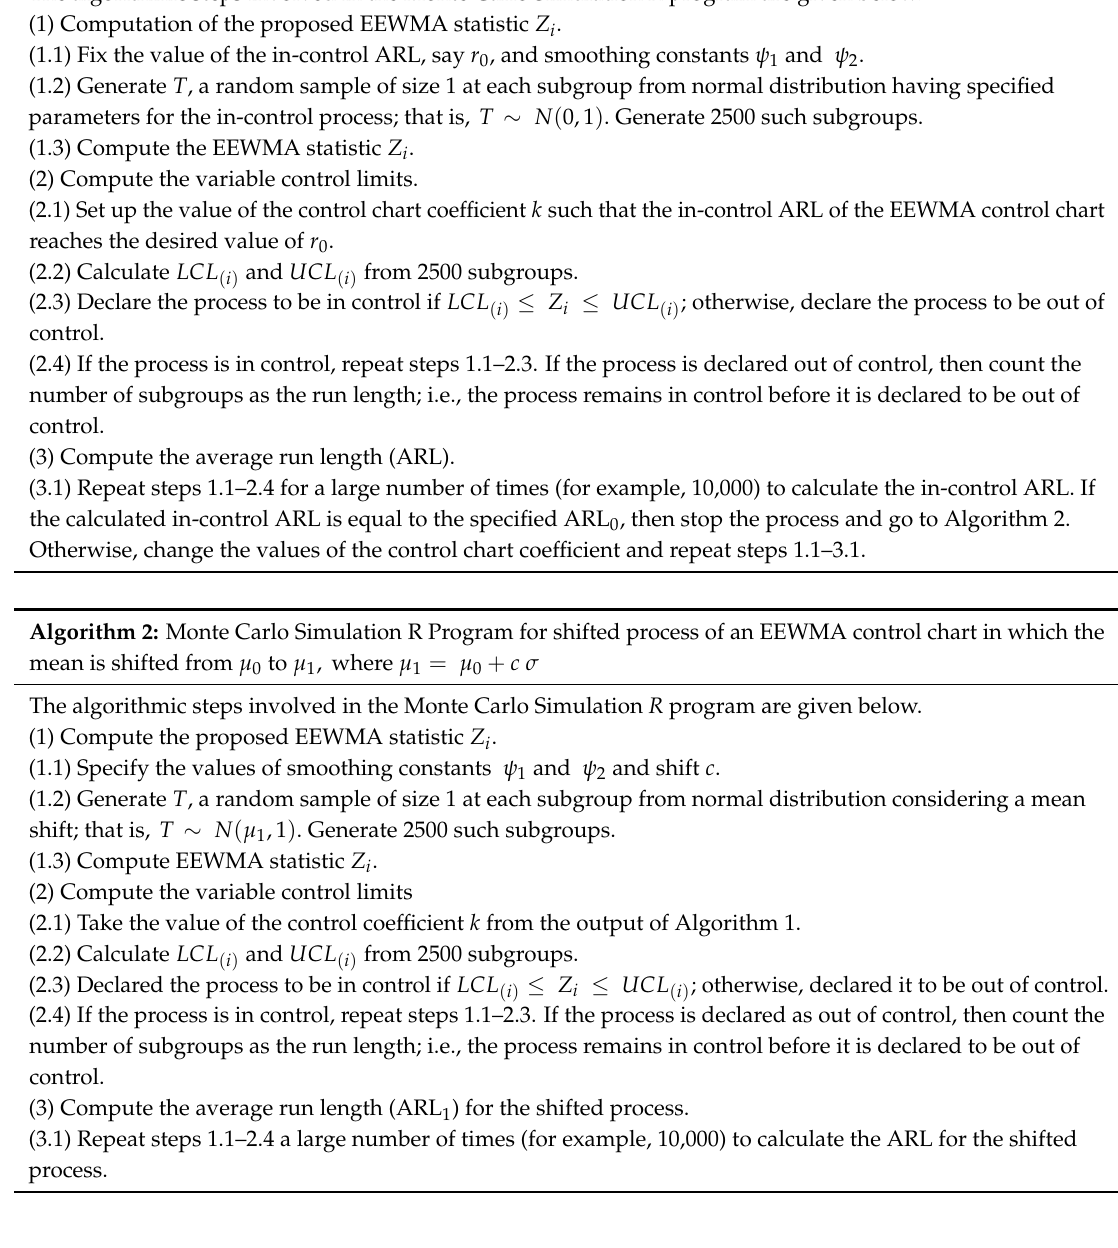
Algorithm 1: Monte Carlo Simulation R Program for in-control process of an EEWMA control chart The algorithmic steps involved in the Monte Carlo Simulation R program are given below.